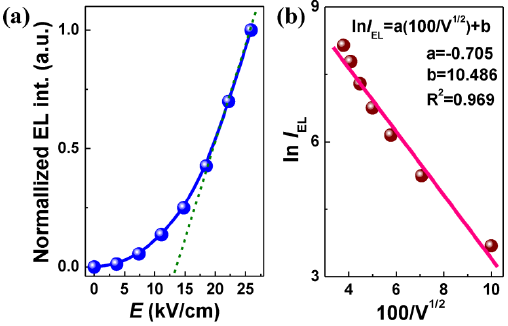
Figure 3. ( a ) Electric field ( E ) dependence of electroluminescent intensity for (Ba 0.4 Ca 0.6 )TiO 3 :Pr 3+ -based device; ( b ) relation of the electroluminescent intensity (ln I EL ) and the applied voltage (100/ V 1/2 ).